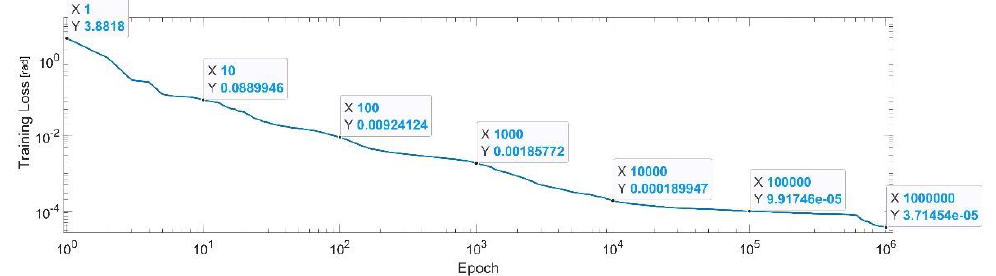
Figure 7. Convergence of the neural network for the first generalized coordinate 𝑞 1 (log scale).